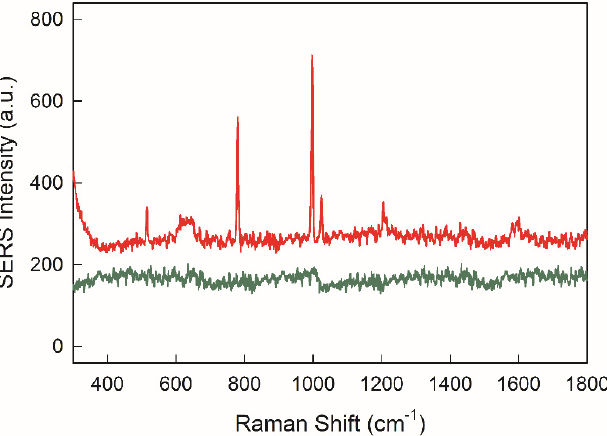
Figure 10. SERS spectra of a 5 mM solution of toluene in water spotted on 1% coated GNS@Ag SERS chip (red line), and on a GNS@Ag SERS chip (green line).